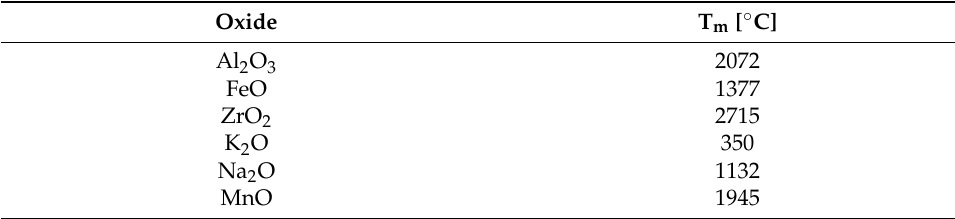
Table 2. Oxide impurities found in the quartz samples and their melting